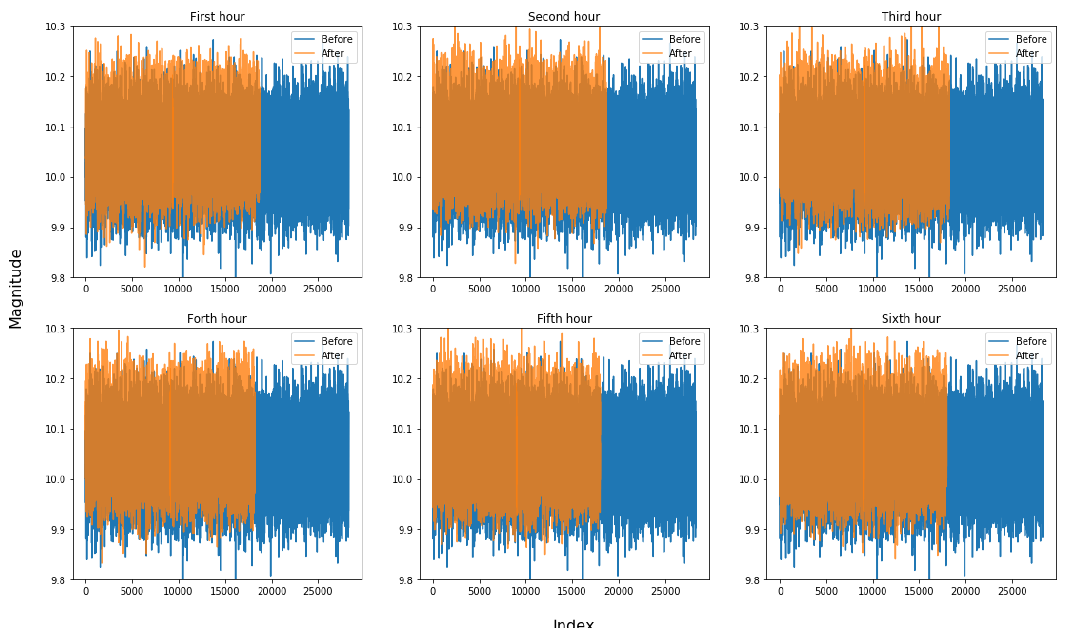
Figure 9. Time domain plot for data collected from outside sensor before and after inserting Red Palm Weevils through hours.